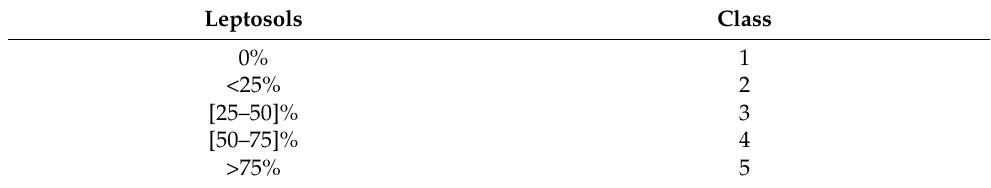
Table 2. Class division for leptosols (LS), depending on the percentage of leptosols in each region.